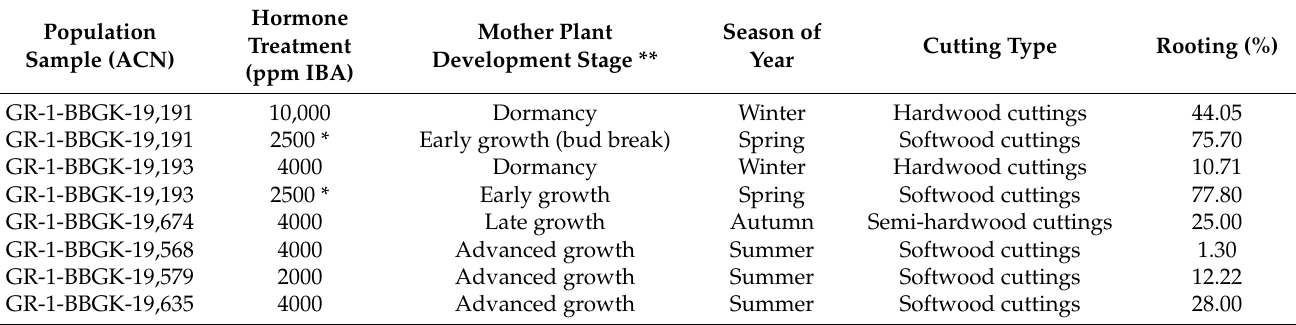
Table 2. Results of preliminary propagation trials on different Greek native genotypes of R. canina utilizing the initial material collected directly from wild-growing populations. The table summarizes the most successful treatments used in terms of rooting frequencies. Original data are included in Table S1.